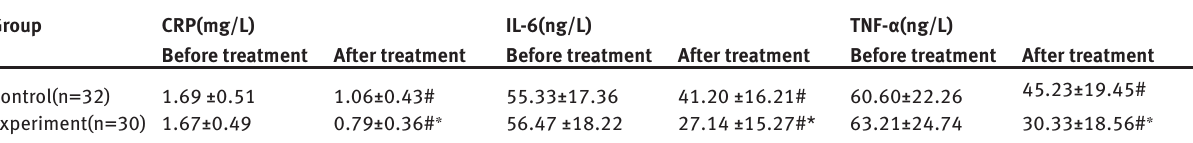
Table 3: Serum level of CRP, IL-6 and TNF-α before and after treatment for both control and experiment group